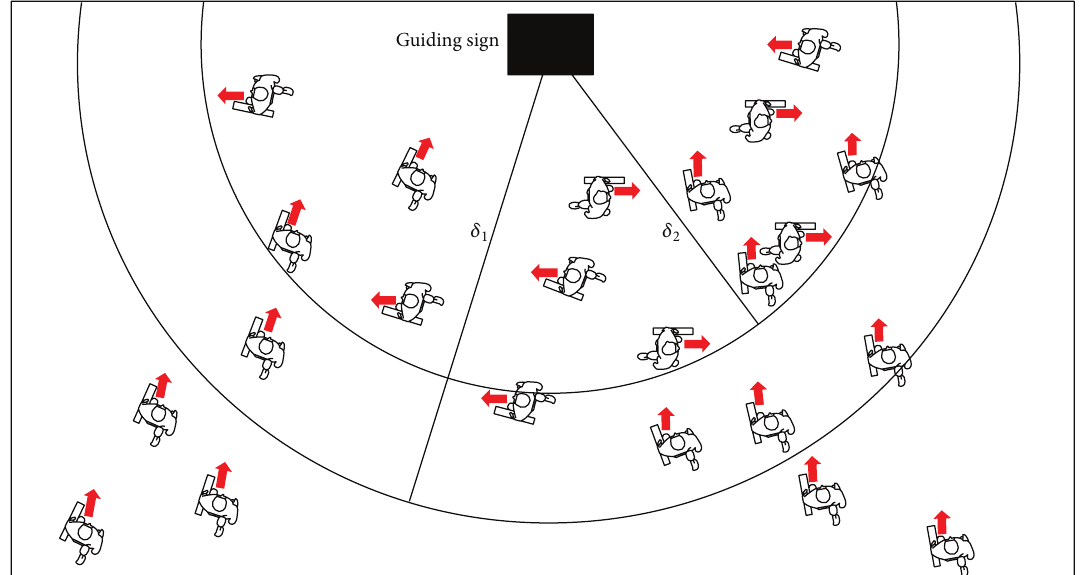
Figure 4: Chart of the influence that guiding signs have on